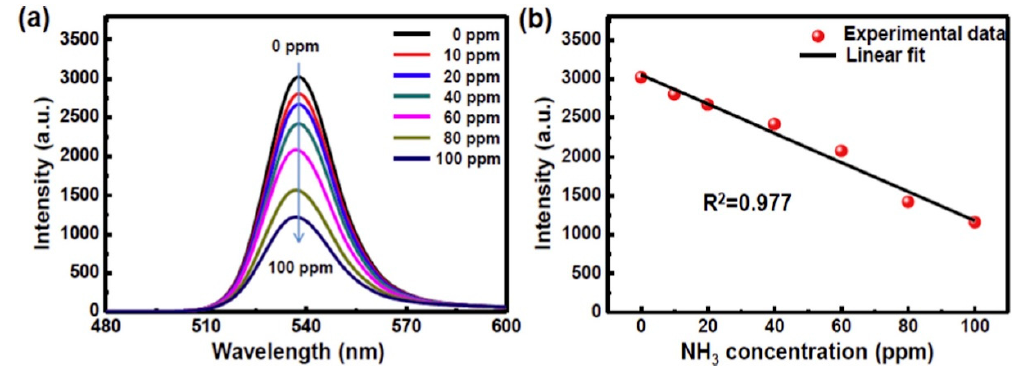
Figure 16. MAPbBr 3 -TBA-based gas sensor. ( a ) The PL quenching toward different concentration of gaseous NH 3 (0–100 ppm) and ( b ) the plot of PL intensity versus concentration of NH 3 (reproduced with the permission from reference [160]).